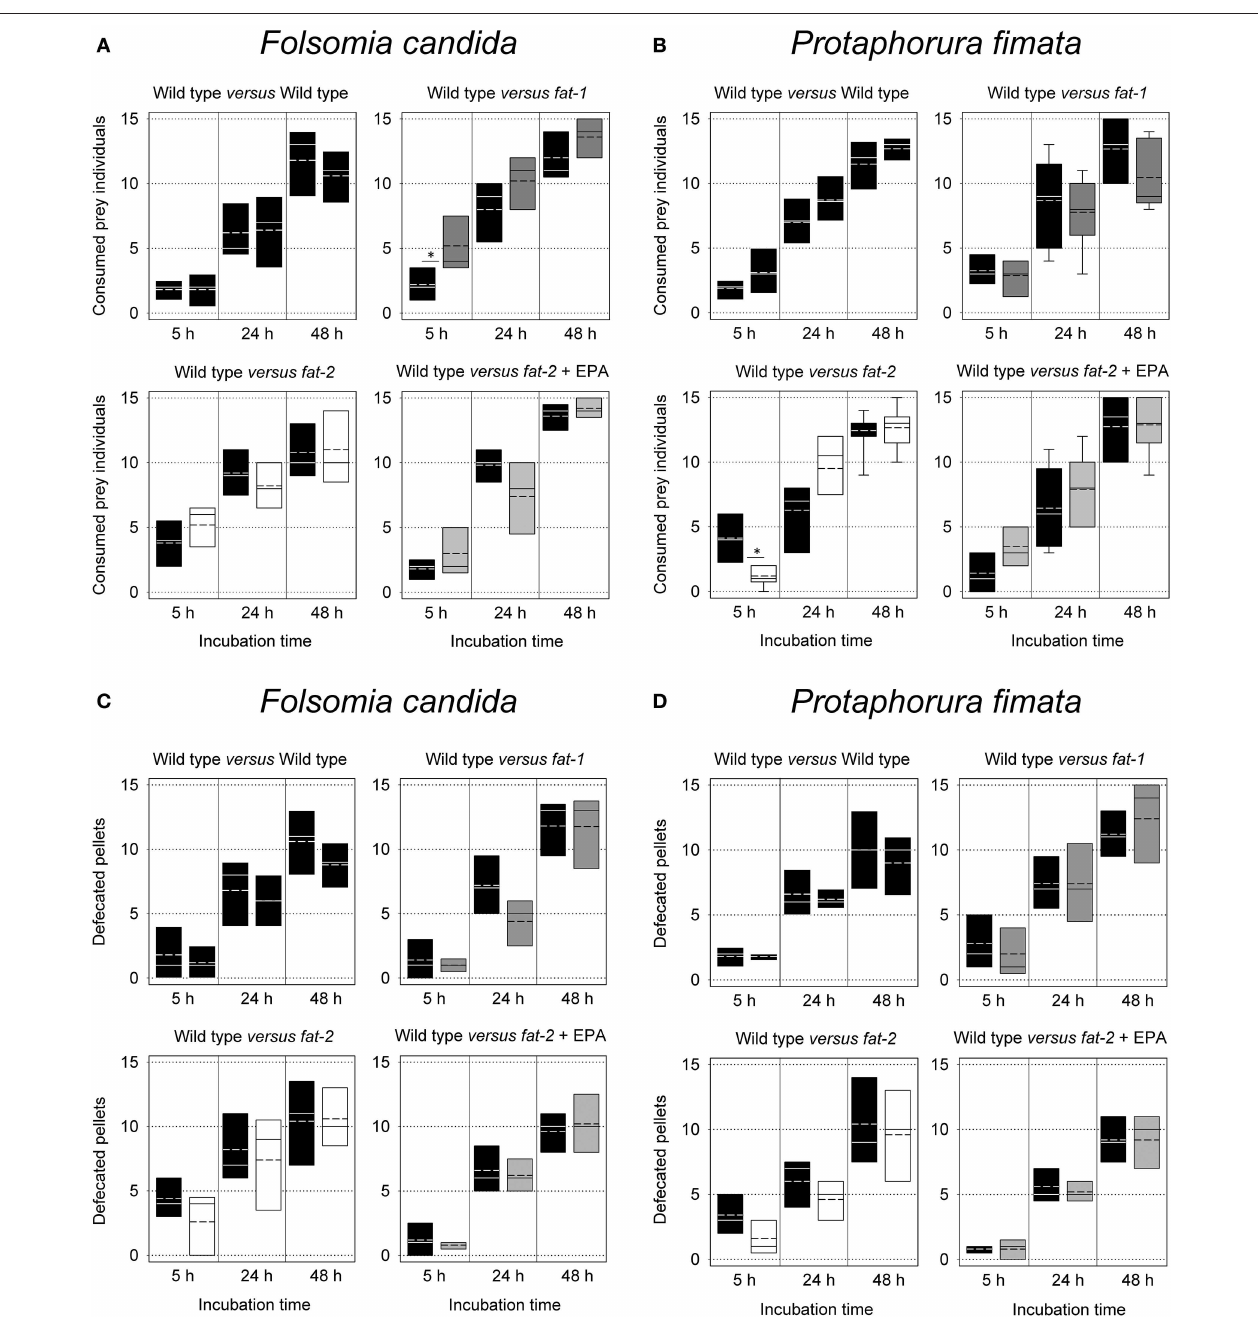
FIGURE 4 | Food preferences of Folsomia candida and Protaphorura fimata for different Caenorhabditis elegans strains [WT – wild type, fat-1 - no ω 3 LC-PUFAs, fat-2 - no LC-PUFAs, fat-2 + EPA (Eicosapentaenoic acid)]. Shown are two experimental scenarios: Consumed prey animals (A,B) presented on once split Petri dishes and fecal pellets (C,D) deposited around the offered food. Box plots show each outlier ( n = 5). Statistical differences were tested within each experimental set. The two significantly different Bonferroni post-hoc test results are represented by stars, the corresponding F - and P -values are: (A) F (1,8) = 7.03, P = 0.029; (B) F (1,8) = 19.69, P =